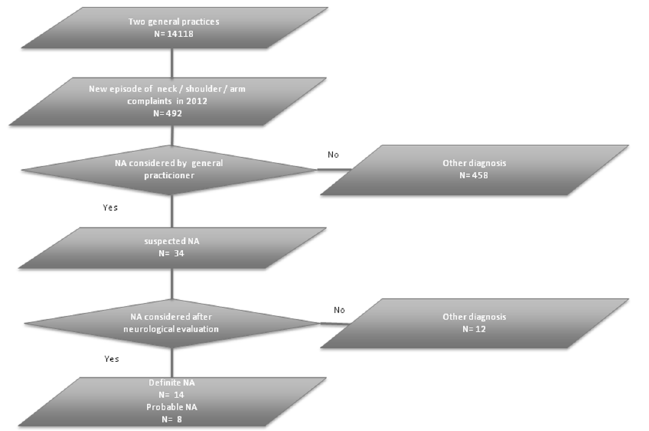
Fig 1. Study flowchart. NA = neuralgic